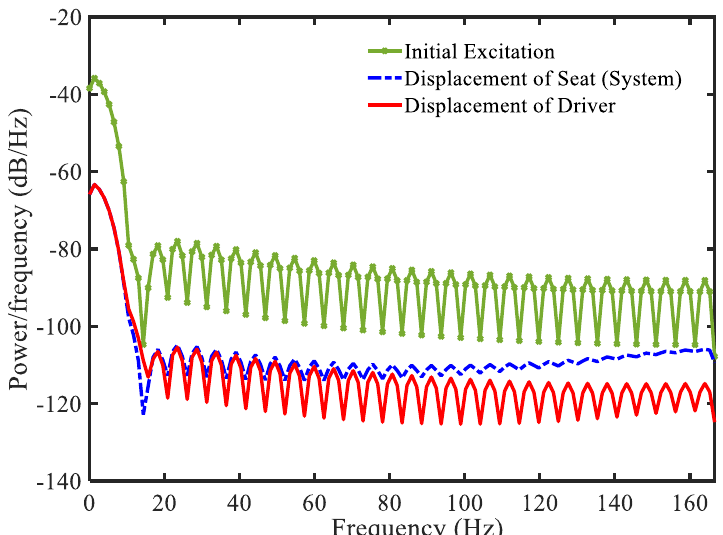
Figure 11. Vibration control results at the driver position under random bump road excitation: ( a ) displacement, ( b ) velocity.